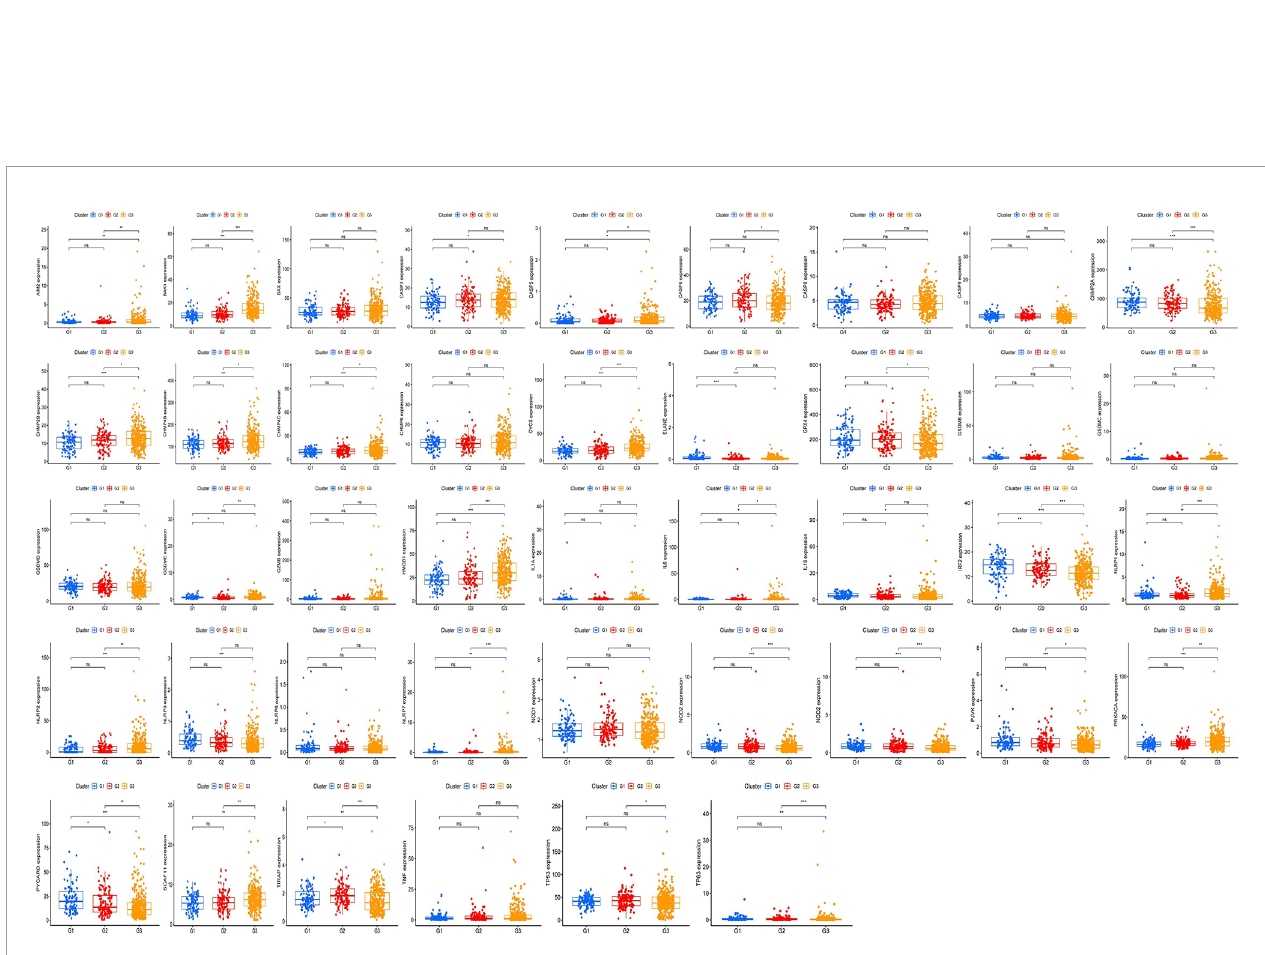
FIGURE 5 | Exploration of the relationship between pyroptosis-related genes and tumor grade. The expression of 42 uterine corpus endometrial carcinoma (UCEC)- associated pyroptosis-related genes in each grade. P-values are shown as: *p <0.05; **p < 0.01; ***p < 0.001, ns means not statistically signi fi